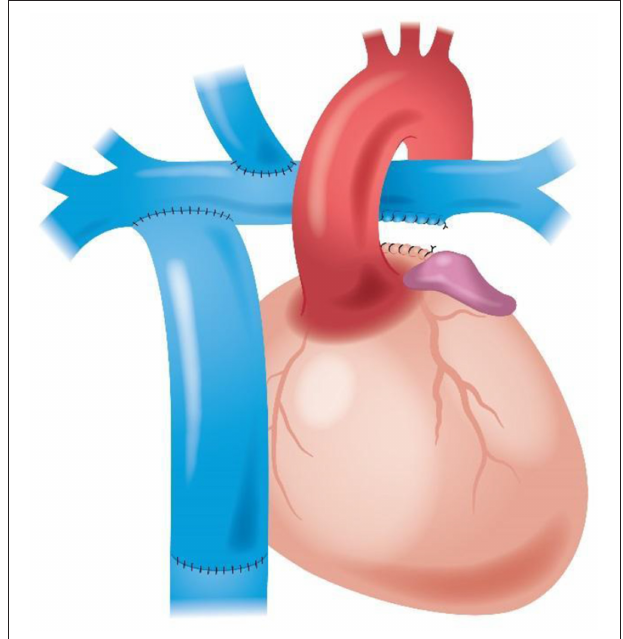
FIGURE 1 | Conceptual arrangement of the new physiological Fontan